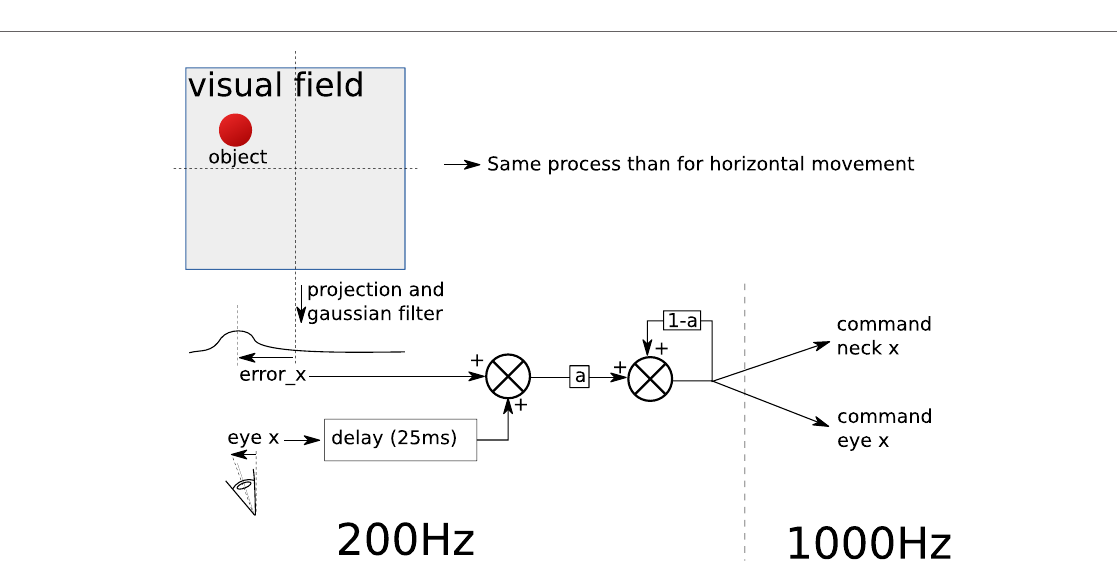
FIGURE 14 | Architecture of the system processing the visual field and sending command to the eye and neck of the robot in order to keep the head facing a target (the ball) where eye x is the proprioceptive signal related to the eye current orientation and error x is the distance of the target to the center of the camera field of view